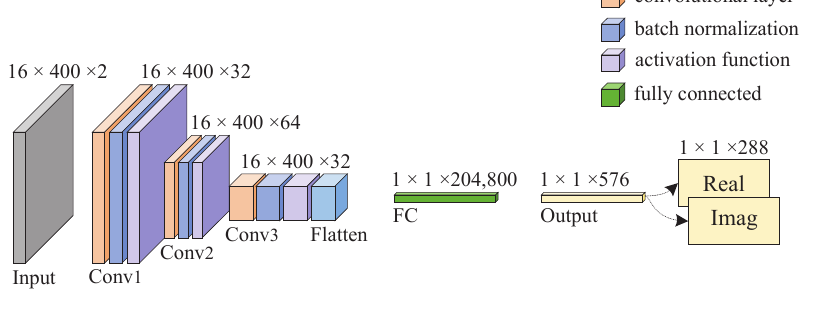
Figure 3. Details of the WBPNet with 400